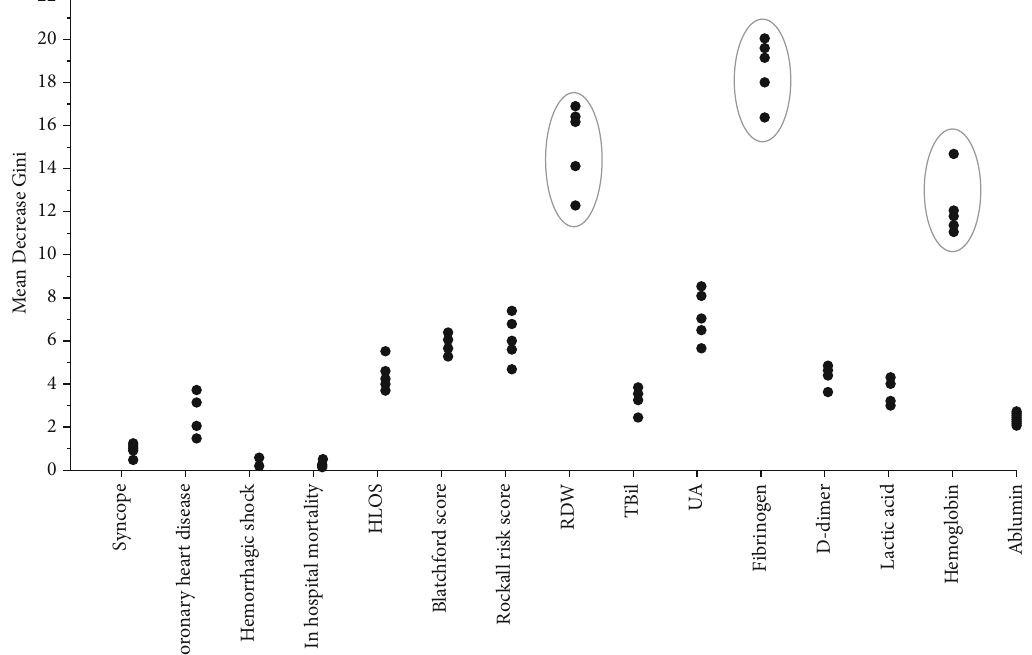
Figure 2: The Mean Decrease Gini of risk factors associated with ACS based on random forest analysis with fi vefold cross-validation. The MDG represents the weight of each risk factor by univariate analysis associated with ACS in this model. With MDG sequencing, fi brinogen, RDW, and hemoglobin were ranked the top three risk factors associated with ACS in each of the fi vefold